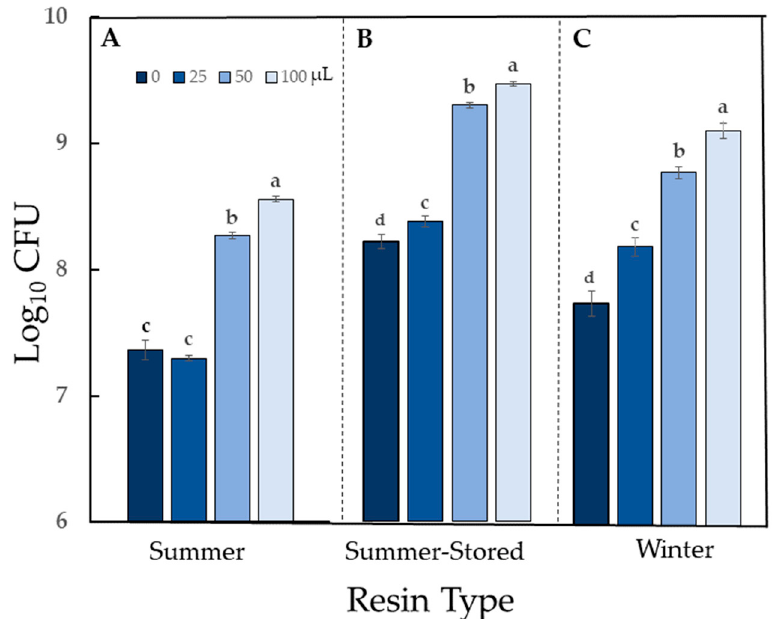
Figure 3. Growth stimulation of Pseudomonas fluorescens with autoclaved Sv resin: ( A ) Resin collected in summer and evaluated within 72 h. ( B ) Resin collected in summer and stored at –20 °C for 6 months before evaluation. ( C ) Resin collected in winter and evaluated within 72 h. Treatment doses (0, 25, 50, and 100) are volumes of suspended resin ( μ L) in a total volume of 300 μ L. For each resin type, bars with the same letter are not different according to Tukey’s test at P < 0.0001. Data shown are arithmetic means + standard errors.